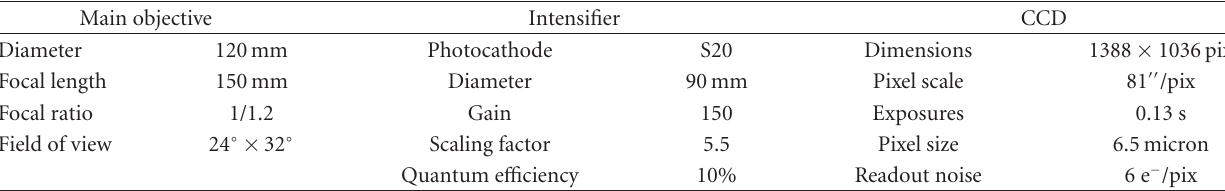
Table 1: Main parameters of the TORTORA camera.